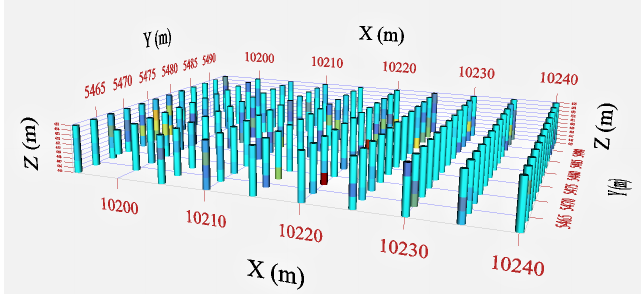
Figure 1. Rectangular blasthole pattern. Gold content is shown in the solid-trace style sized according to gold grade, high grades are marked as red.